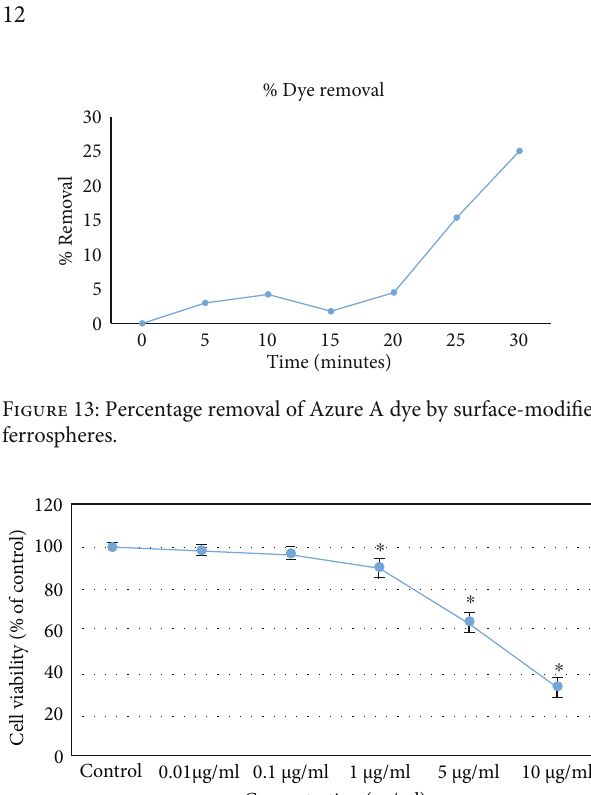
Figure 14. Toxicity of CFA on BEAS-2B cells in a dose- dependent manner and maximum toxicity was observed at 10 μ g/ml CFA (Figure 14). Toxicity of CFA (0.01, 0.1, 1.0, 5.0, and 10 μ g/ml) was observed 1.6%, 3%, 10%, 36%, and 67% for 24h on BEAS-2B cell line, respectively (Figure 14).